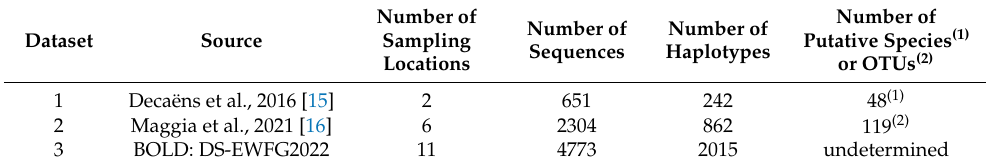
Table 1. Main characteristics of the three datasets used in this